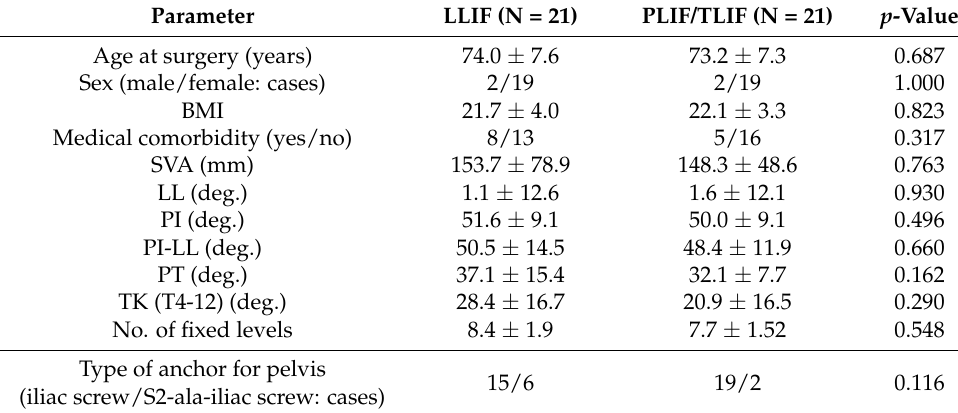
Table 1. Patient characteristics in the lateral lumbar interbody fusion (LLIF) group and the posterior lumbar interbody fusion (PLIF)/transforaminal lumbar interbody fusion (TLIF) group after the matching.